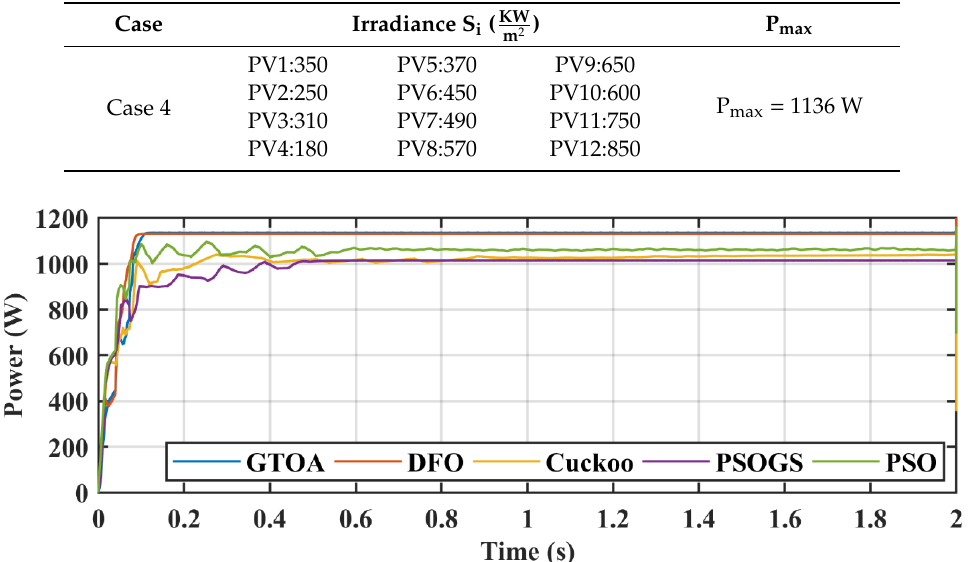
Table 3. Irradiance pattern for CPS.